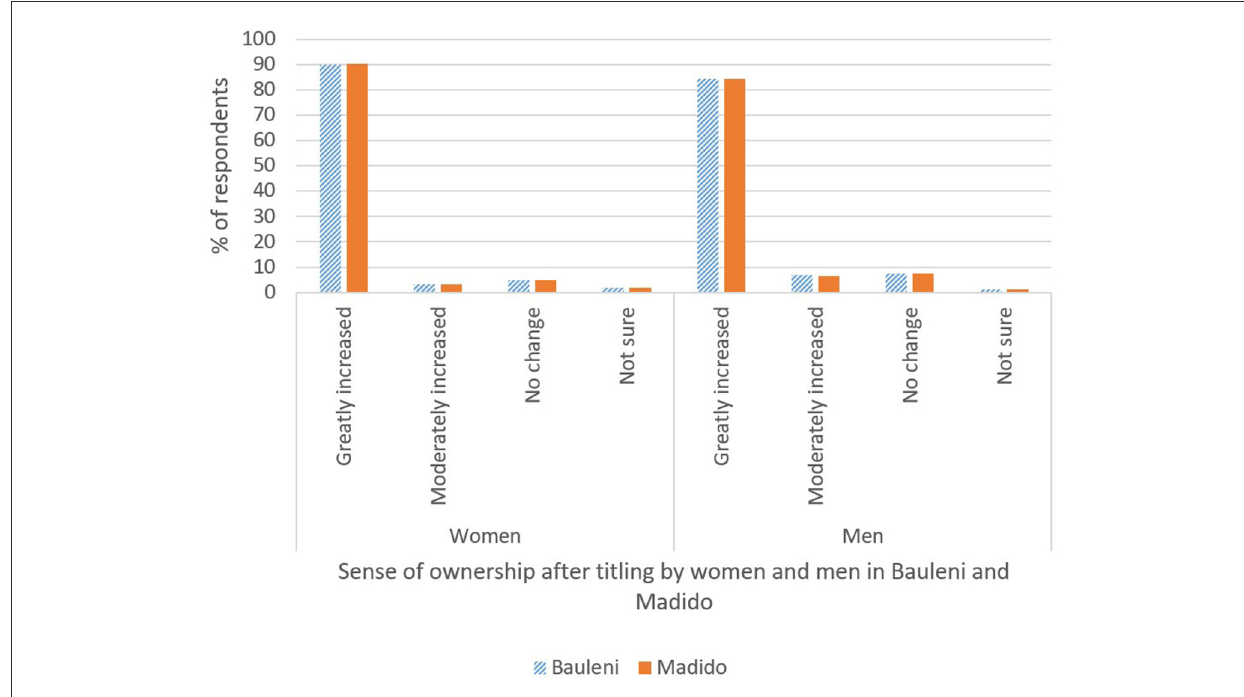
FIGURE4 Sense of ownership by women and men in Bauleni and